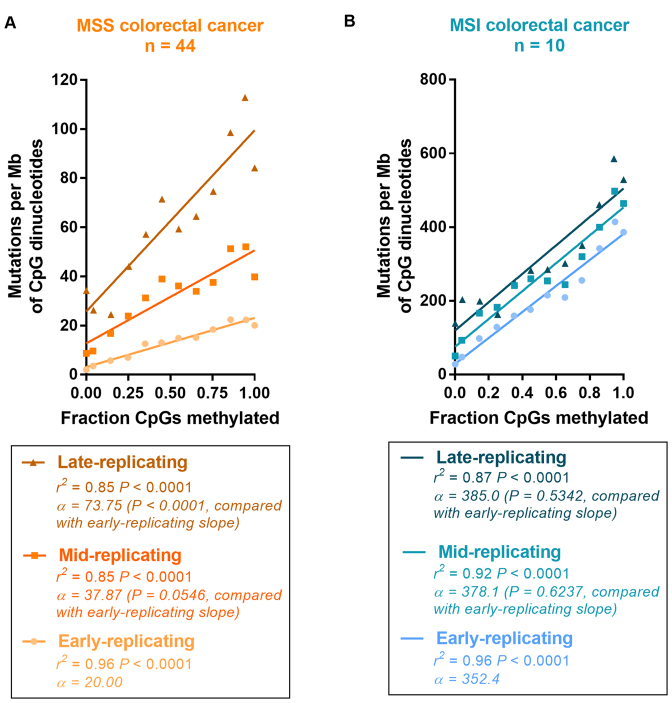
Association between mutation accumulation and methylation across changes in replication timing in colorectal cancers with differential mismatch repair. Correlation between mutations per megabase (Mb) at CpG dinucleotides and fractions of CpGs methylated (using normal sigmoid colon tissue WGBS methylation data) across autosomes in (A) microsatellite stable (MSS) colorectal cancers, and (B) colorectal cancers with microsatellite instability (MSI). Genome-wide data is binned for each colorectal cancer subtype (bins of 0.1 methylation), along with r2 and significance from Pearson's regression. The comparison of mid- and late-replicating slopes with early-replicating slopes was calculated by linear regression on binned data, with ‘early-replicating’ as the reference factor.